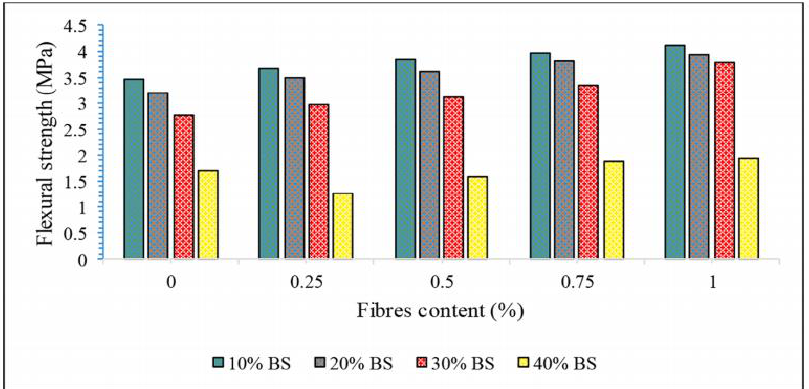
Figure 9. Flexural strength of PFRG with different contents of sisal fiber and bamboo stick(BS) [111].